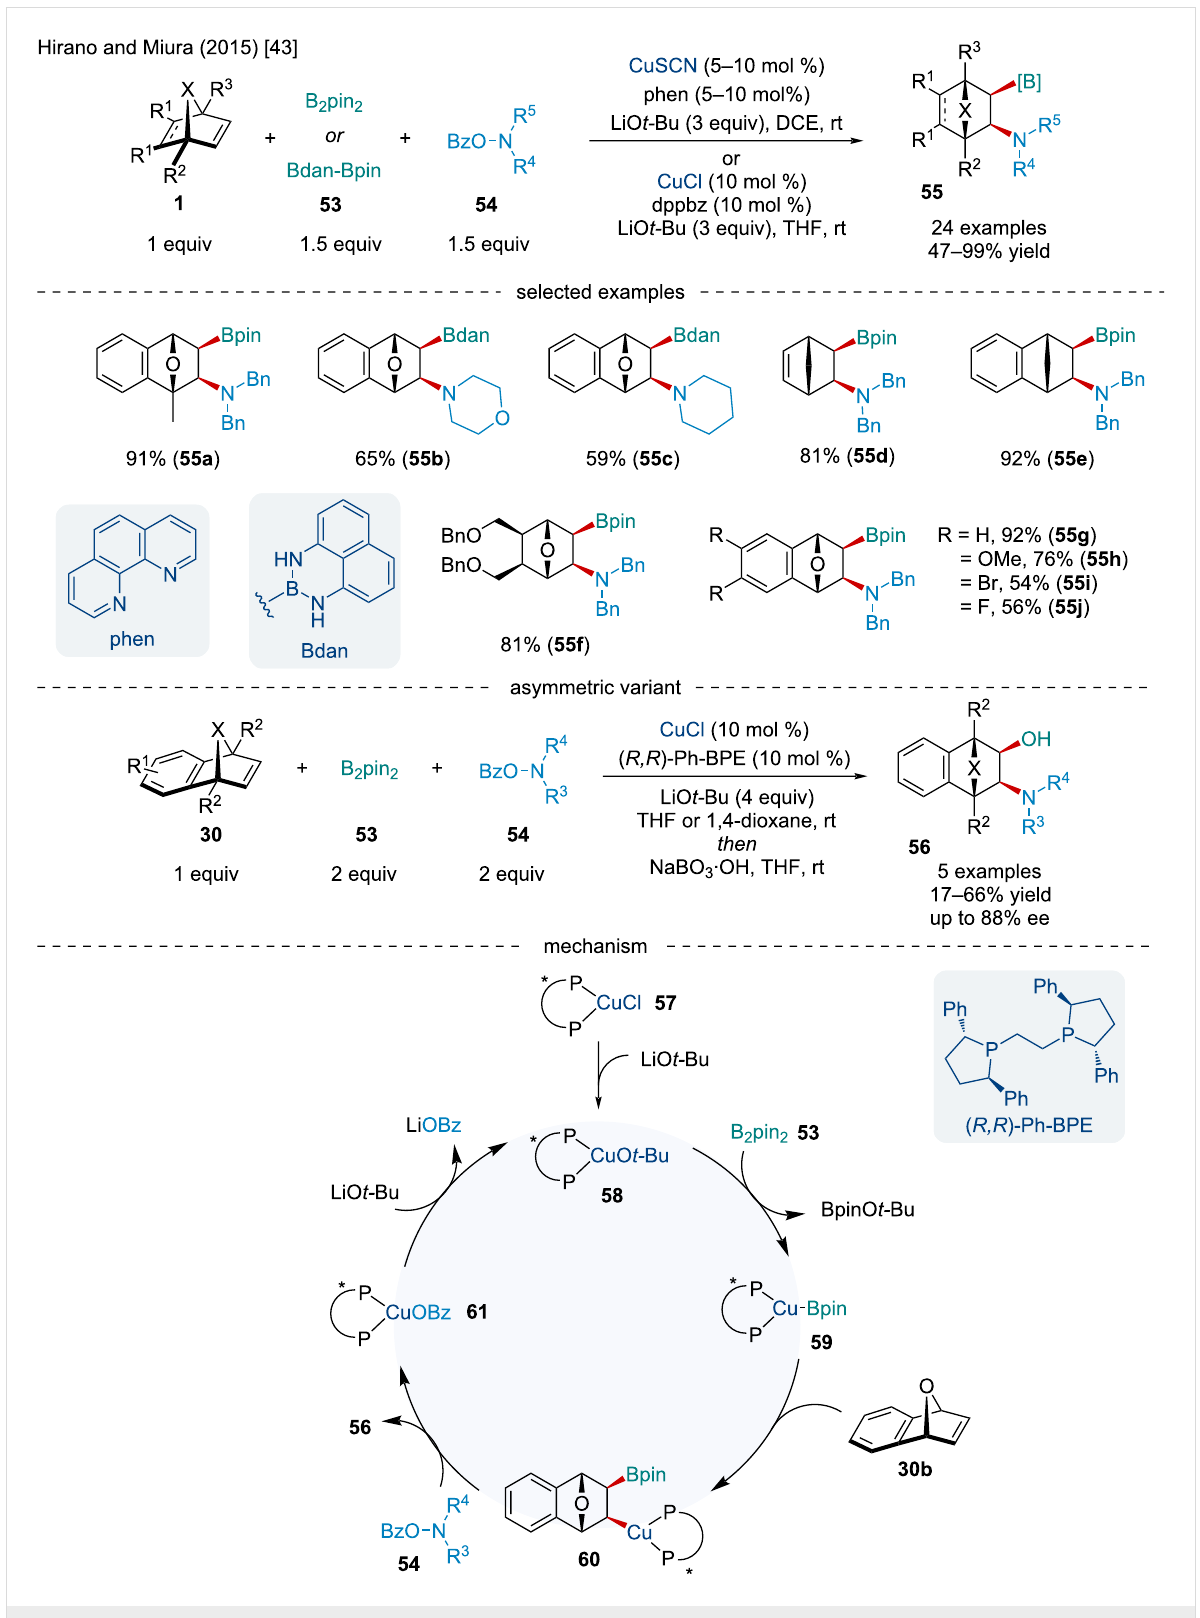
Scheme 9: Cu-catalyzed aminoboration of bicyclic alkenes 1 with bis(pinacolato)diboron (B 2 pin 2 ) ( 53 ) and O -benzoylhydroxylamine derivatives 54